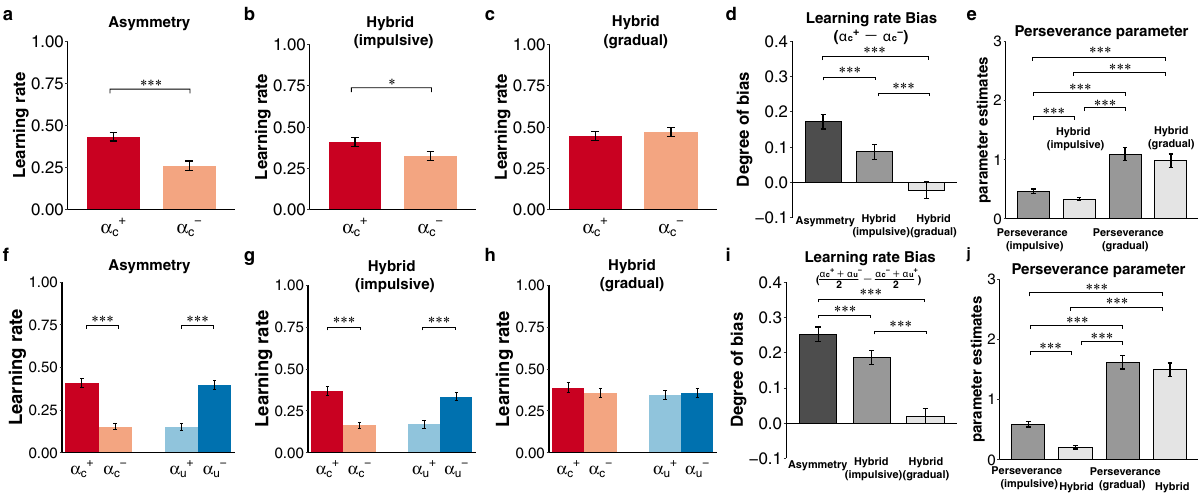
Figure 4. The results of the web-based experiment. The rows show the results of the web-based experiment in the factual and counterfactual learning contexts. The first to third columns represent the learning rates in the Asymmetry ( a , f ), Hybrid (impulsive) ( b , g ), and Hybrid (gradual) models ( c , h ). ( d , i ) The fourth column indicates the degree of learning rate bias (i.e., positivity bias in the factual context and confirmation bias in the counterfactual context). ( e , j ) The final column shows the perseverance parameter ( φ ) in the Perseverance (impulsive), Perseverance (gradual), Hybrid (impulsive), and Hybrid (gradual) models. *** p < 0.001, ** p < .01 and * p < 0.05. The error bars represent the standard error of the